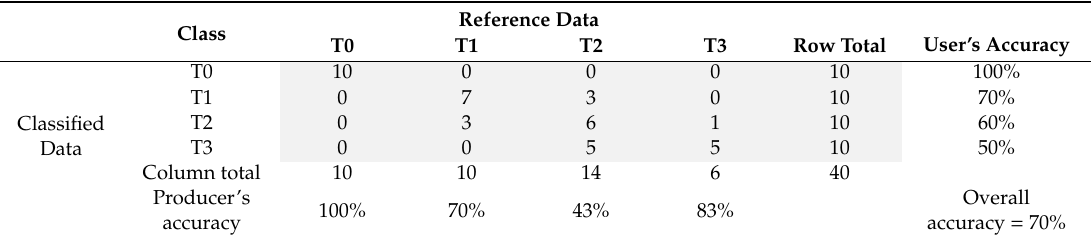
Table 13. Confusion matrix of ESD (input of PC1, PC2, and PC3) using three features: crown pixel, frond number, and frond